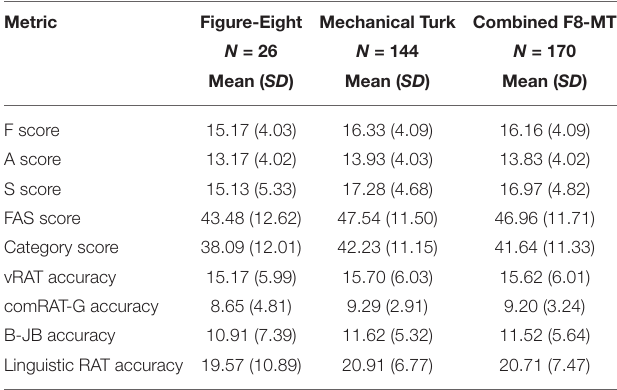
TABLE 2 | Means and Standard Deviations of verbal fluency scores and accuracy performance on the visual and linguistic Remote Associates Test–Study-2. Metric Figure-Eight Mechanical Turk Combined F8-MT